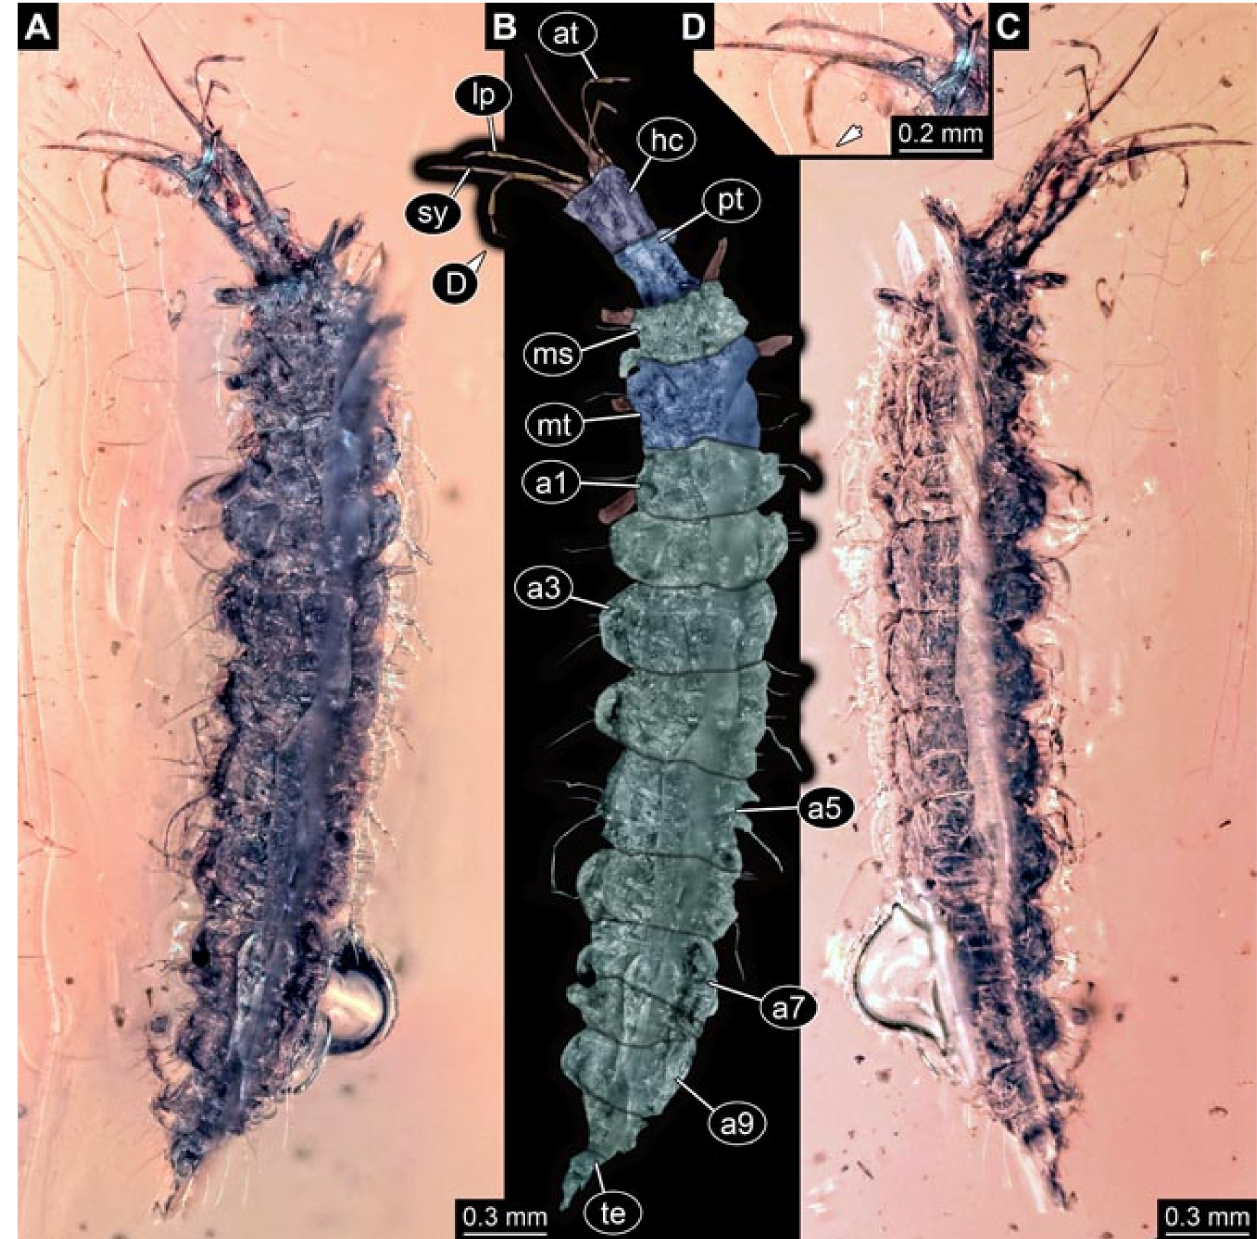
Figure 29. Specimen 5860 (PED 0587); Myanmar amber. ( A ) Dorsal view. ( B ) Dorsal view, colour-marked. ( C ) Ventral view. ( D ) Close-up of antenna with prominent setae (arrow). Abbreviations: a1–a9 = abdomen segments 1–9; at = antenna; hc = head capsule; lp = labial palp; ms = mesothorax; mt = metathorax; pt = prothorax; sy = stylet; te = trunk